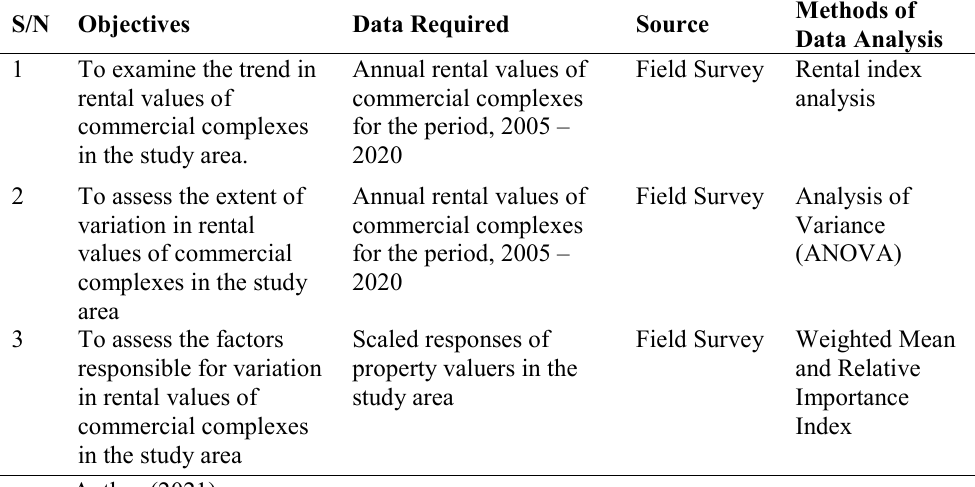
Table 2. Research Objectives and Data Analysis